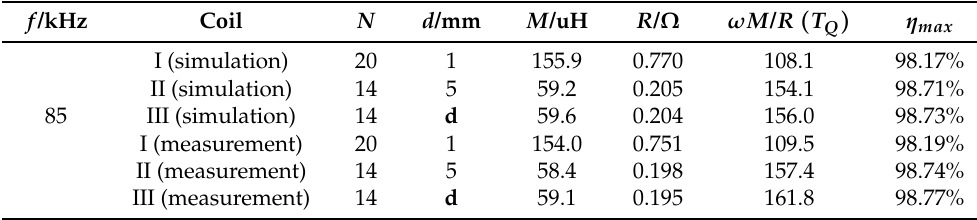
Table 2. Performance comparison of the coils.